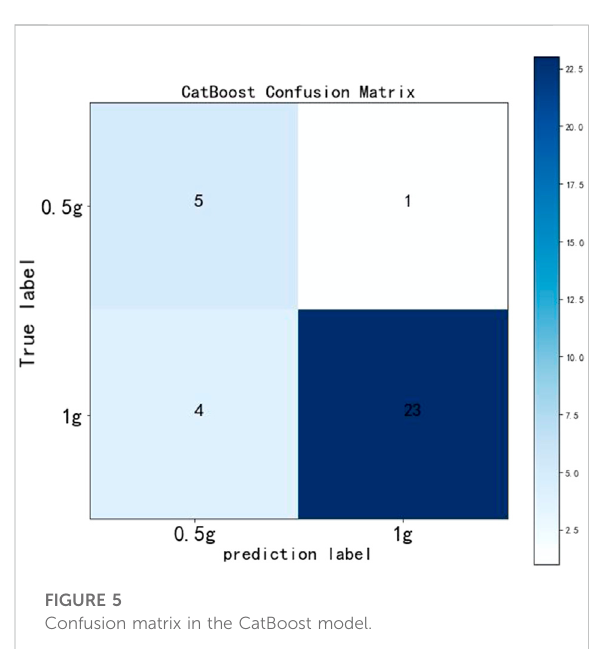
FIGURE 5 Confusion matrix in the CatBoost